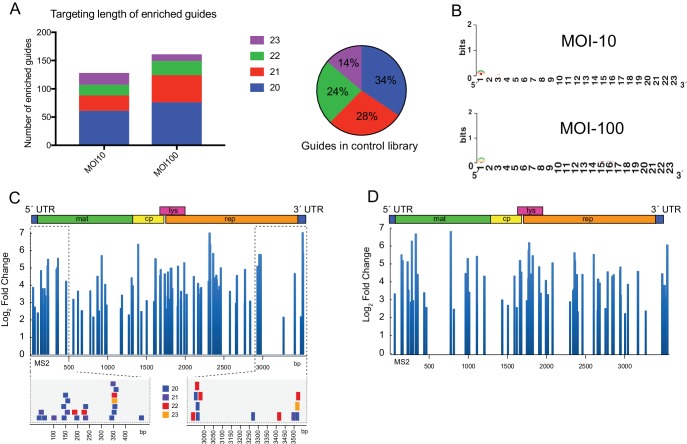
Enriched guides do not display sequence bias and cluster to regions on the MS2 genome.(A) (Left) Stacked bar graph of positively enriched guides (FDR-adjusted p-value<0.05) for perfectly complementary and single-nucleotide mismatch (SNP) guides for a multiplicities of infection (MOI) of 10 and 100. (Right) Percentages of perfect and SNP guides by length averaged across the control libraries (n = 3). (B) WebLogo (Crooks et al., 2004) representation of positively enriched guides (perfect complementarity, FDR-adjusted p-value<0.05) for MOI-10 (n = 84) and MOI-100 (n = 107). Different length guides were aligned at their 3´ end, which contains the pre-ordered ‘seed’ region (Jiang et al., 2015). (C) (Upper) Log2 fold-change of positively enriched guides (FDR-adjusted p-value<0.05) mapped to the MS2 genome for MOI-100 treatment. Schematic of MS2 genome is provided above. (Lower) Individual guides mapped to highlighted regions of MS2 genome. (D) Log2 fold-change of guides with an FDR-adjusted p-value<0.05 mapped to the MS2 genome for MOI-10 treatment.10.7554/eLife.32724.018Figure 3—figure supplement 1—source data 1.Enriched guide length distribution, sequences, and targeting location on MS2 genome.